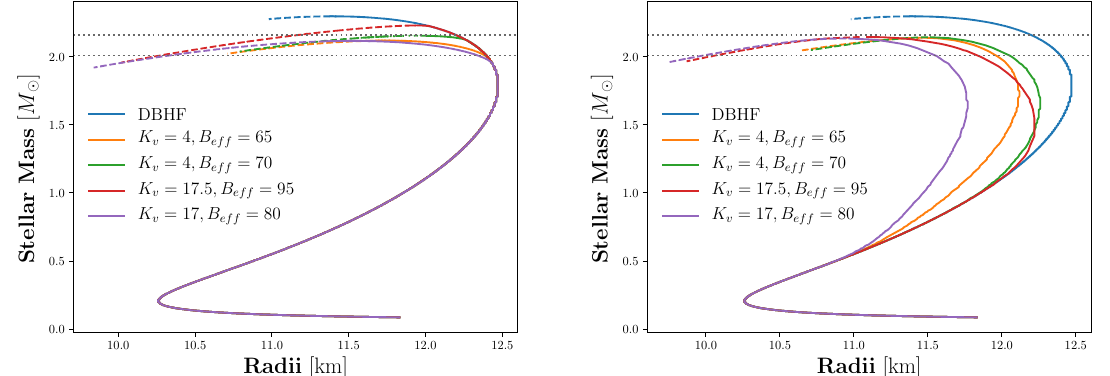
Figure 2. The mass-radius curves obtained solving the TOV Solution from equations (3) for the various hybrid configurations shown in Figure 1. The image to the left displays hybrid configurations with a Maxwell construction, and the image to the right illustrates these same configurations with Gibbs configurations. It is to be noted that the dashed portions of the Mass–Radii curves indicates regimes of unstable star configurations. The region bounded by the grey dashed lines represent the M max constraints applied to our